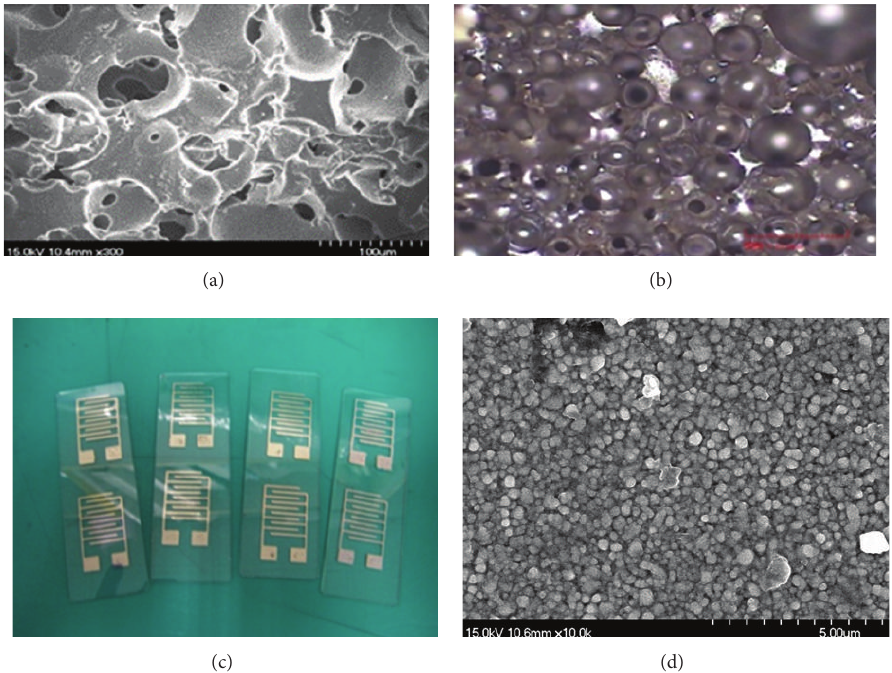
Figure 2: Photographs of (a) sponge of the stamp; (b) sponge loaded with silver ink; (c) final IDEs obtained in this work; (d) SEM of top surface of silver electrode after sintering.